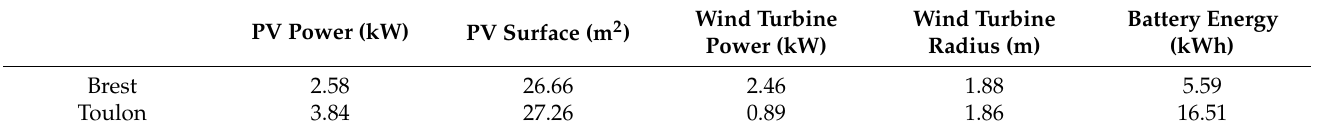
Table 3. Case study 1: PV, wind turbine, and battery optimal sizing.